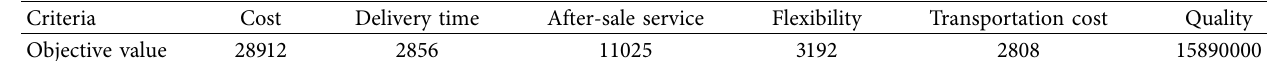
Table 7: Ideal values for set goals.